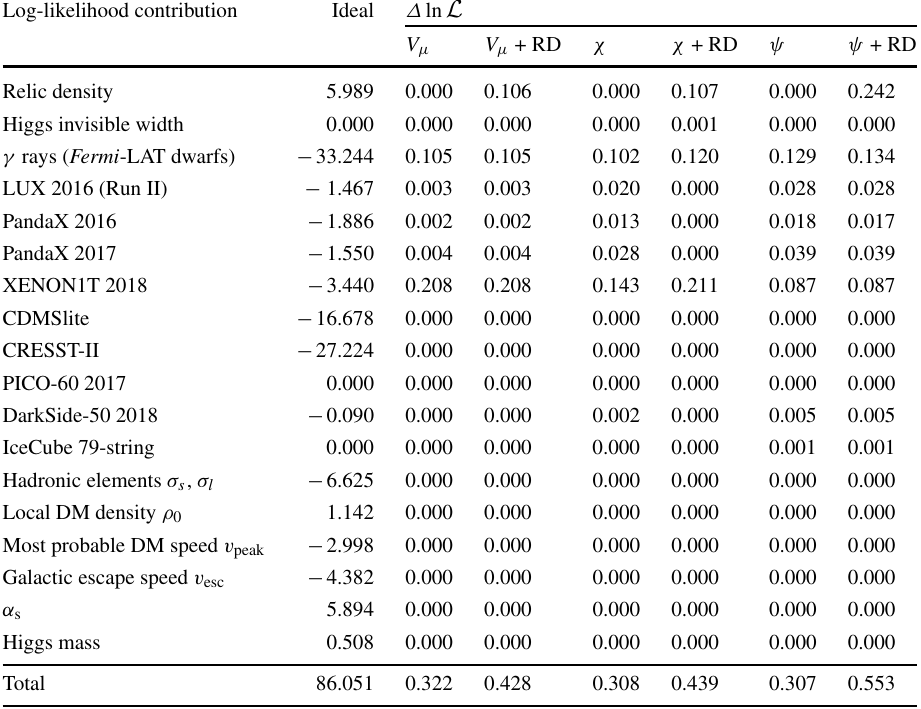
Fig. 6 Profilelikelihoodinthe ( m ψ ,λ h ψ /Λ ψ ) planeforDiracfermion DM.Contourlinesshowthe1and2 σ confidence regions.Theleftpanel gives an enhanced view of the resonance region around m ψ ∼ m h / 2. The right panel shows the full parameter space explored in our fits. The greyedoutregionshowswhereourapproximateboundonthevalidityof